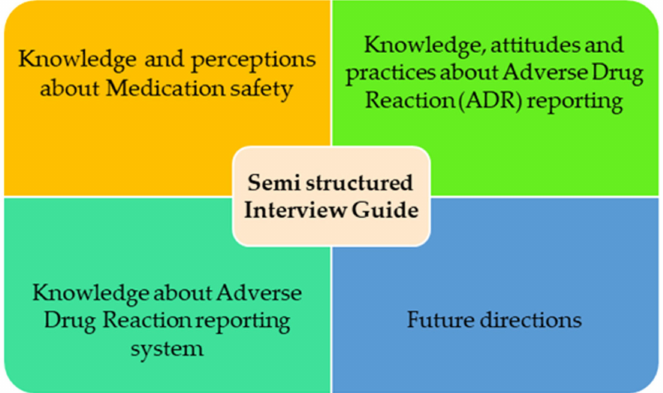
Figure 1. Summary of the topic guide for the semi-structured